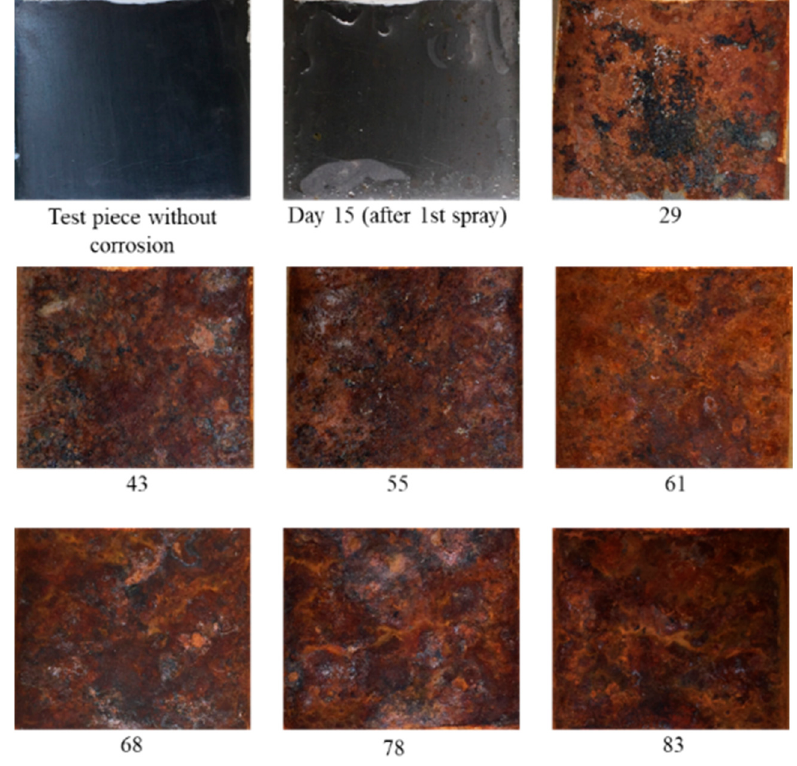
Figure 9. Picture of corrosion evolution for 83 days of measurement. Strain are from the sprayed salt water, shown in the picture at Day 15.